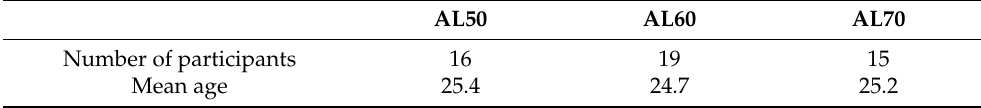
Table 1. Participant information in each session.